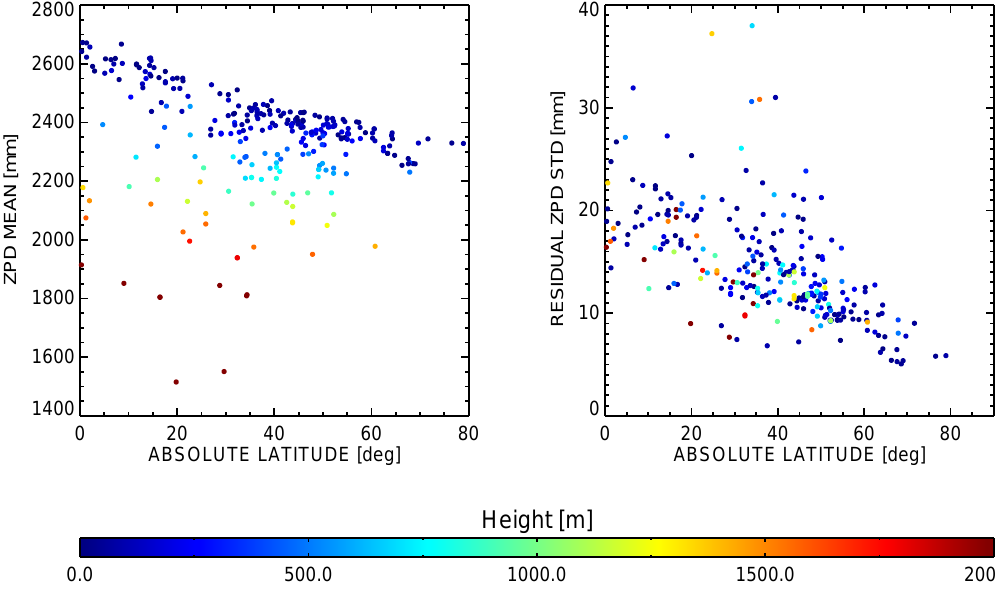
Figure 4. Dependency on absolute latitude of mean ERA-Interim ZPD and standard deviation of ZPD residuals with respect to GPS ZPD evaluated at IGS stations. ( Left ) Mean integrated ZPD as a function of absolute latitude. ( Right ) Standard deviation of the difference between integrated and GPS ZPD as a function of absolute latitude. The color coding is used to indicate the height of the IGS